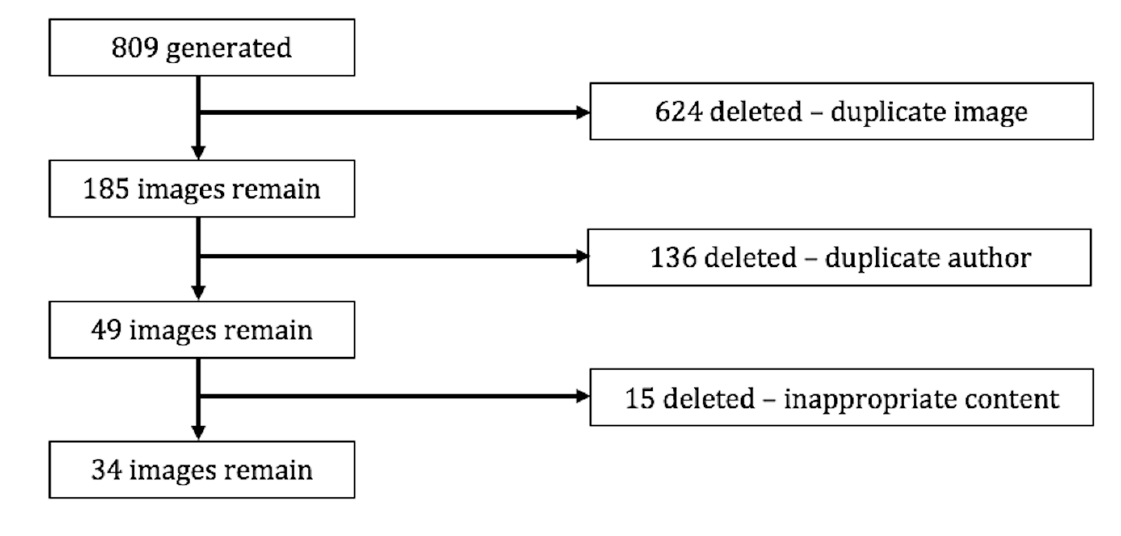
Figure 2. Inclusion tree for images tagged with #amputeefitness and reasons for exclusion from analysis.